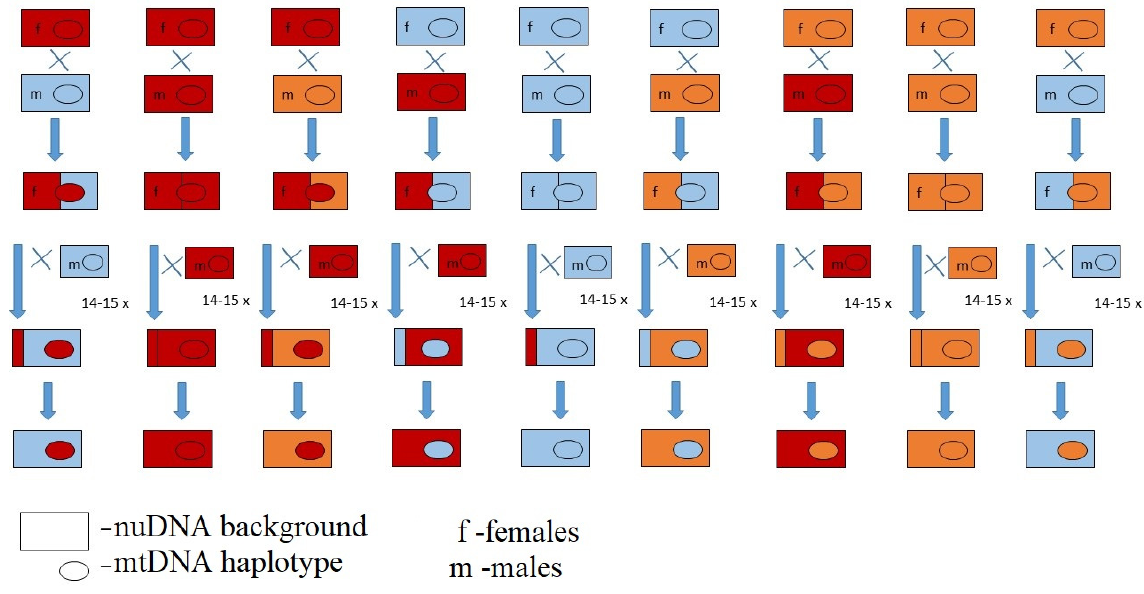
Figure 1. Full backcrossing design for each experimental block.